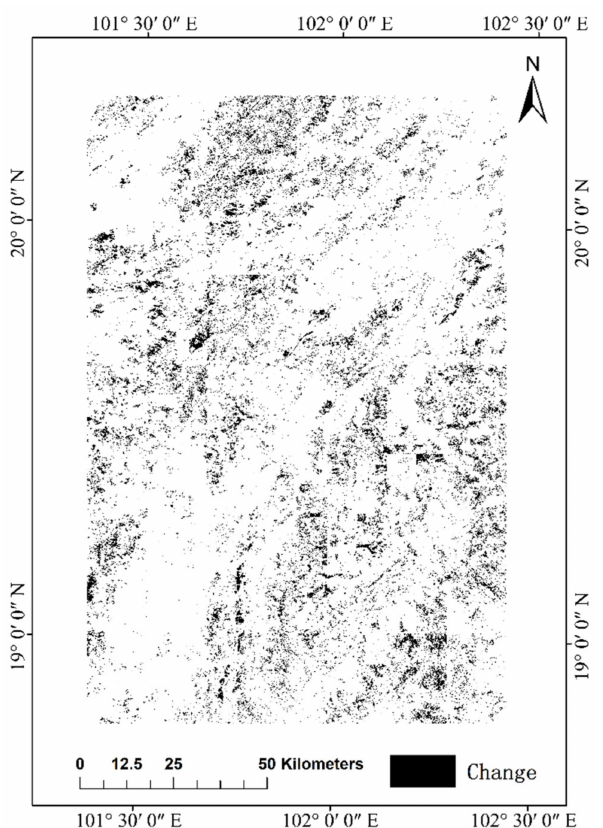
Figure 14. Spurious changes detected by the eco-geographical zoning knowledge base. Figure 15a–d shows patches that were identified as forests transformed into forests, shrubs transformed into shrubs, cropland transformed into cropland, and grass trans- formed into